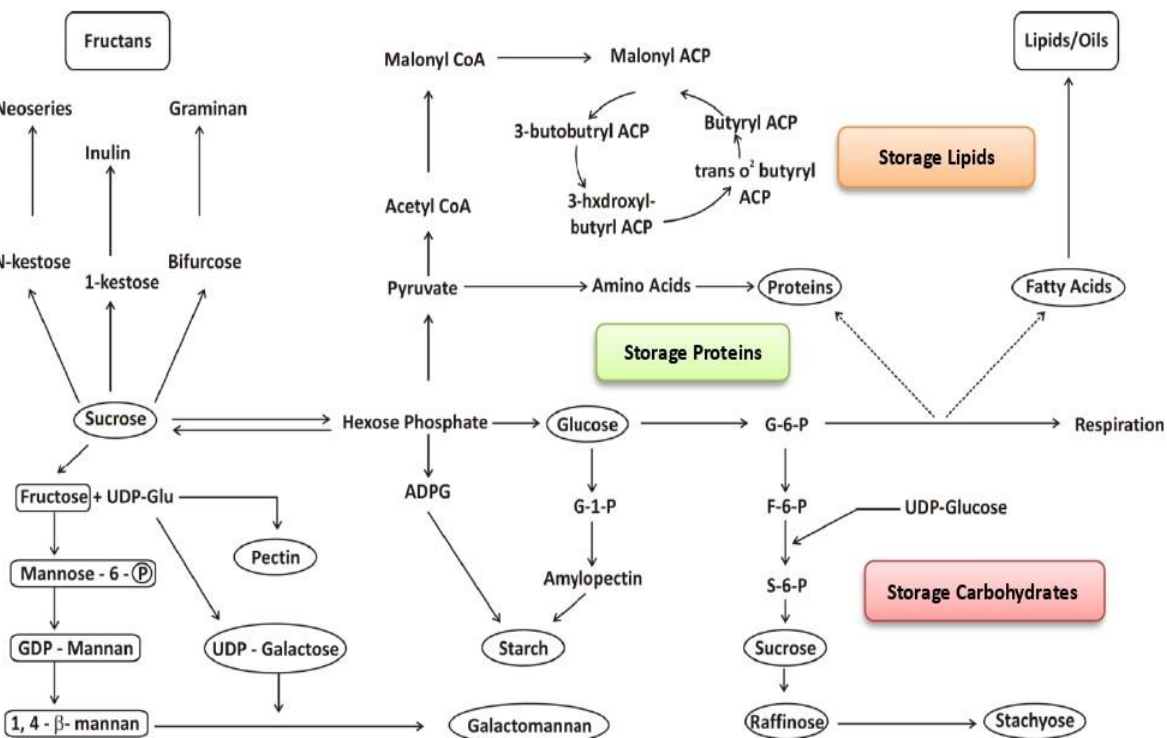
Figure 1. Crosstalk of various biochemical pathways during seed storage reserve biosynthesis starting from the precursor sucrose. Abbreviations: ADPG: ADP-glucose; F-6-P: fructose-6-phosphate; G-1-P: glucose-1-phosphate; G-6-P: glucose-6- phosphate; S-6-P: sucrose-6-phosphate; UDP-Glu: UDP-glucose.